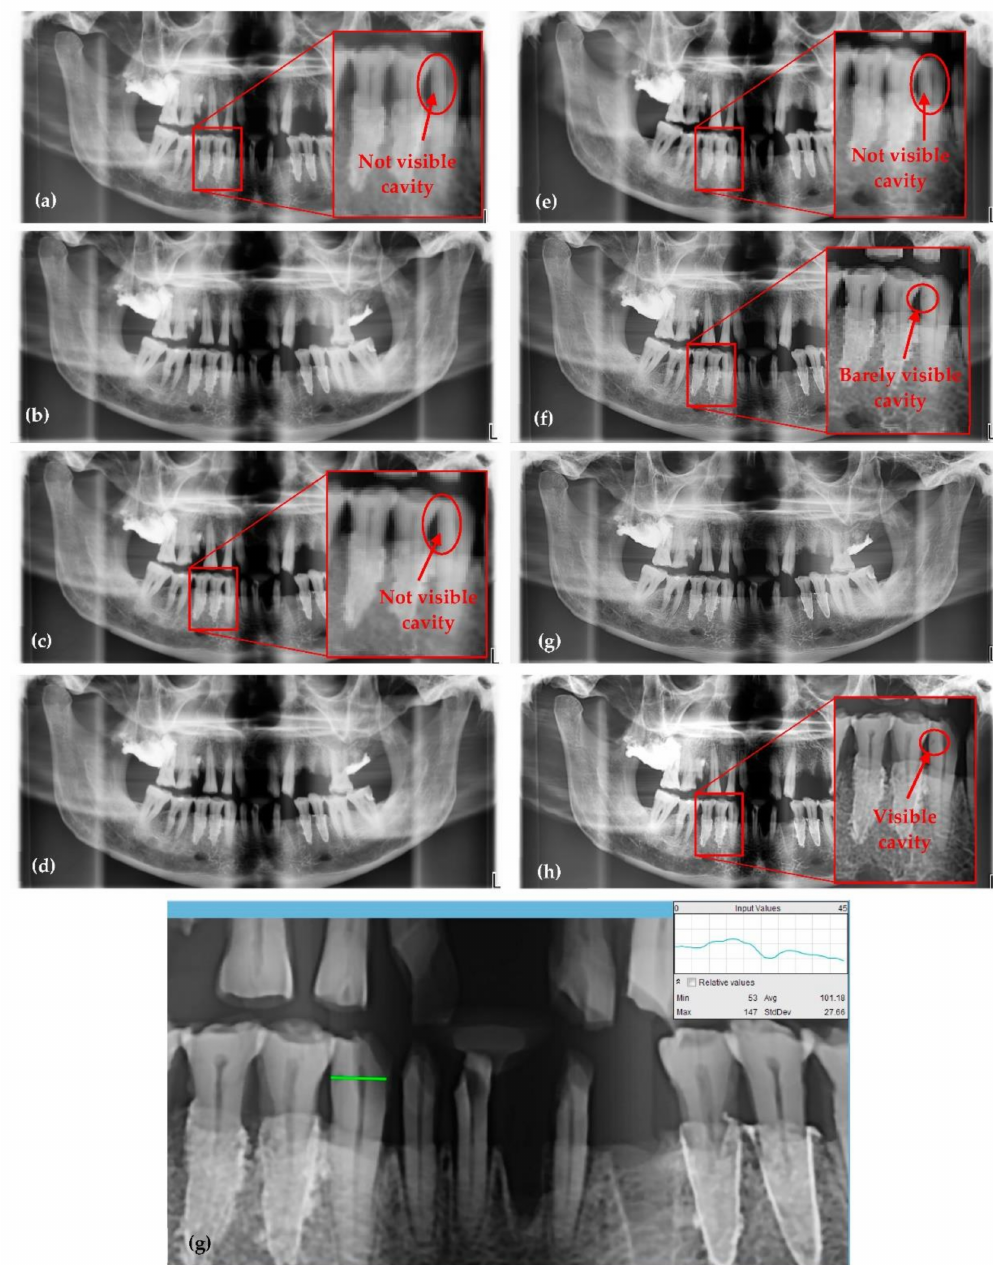
Figure 8. ( a – h ) Panoramic radiographs obtained during the optimization process. ( g ) Area with detail (small cavity) followed on each radiography image using OCT images as reference. The settings of the X-ray unit to perform each image and the quality parameters around the small cavity are provided in Table 1. The quality parameters of the entire radiographic images are compared in Table